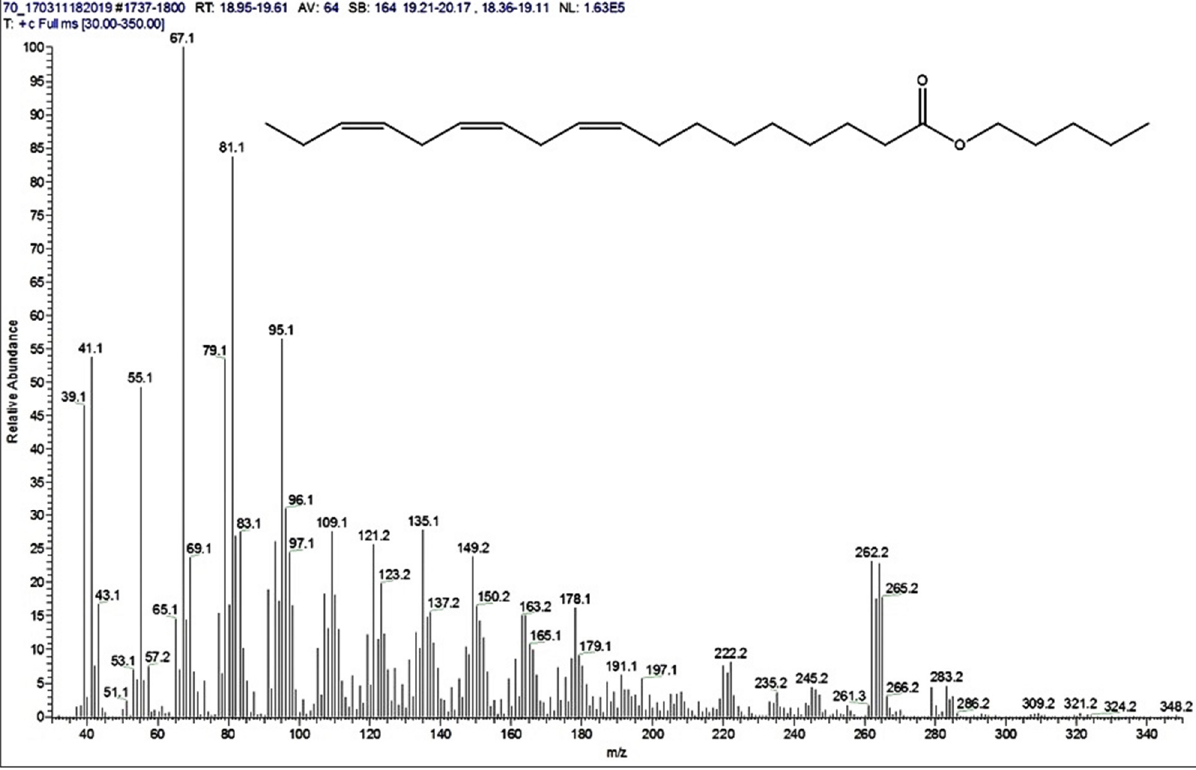
Figure 5. The mass spectrum of the ester, corresponding to the peak separated on the GC column at 17.70 min retention time (M = 326 g/mol), in the case of B3 bioester.